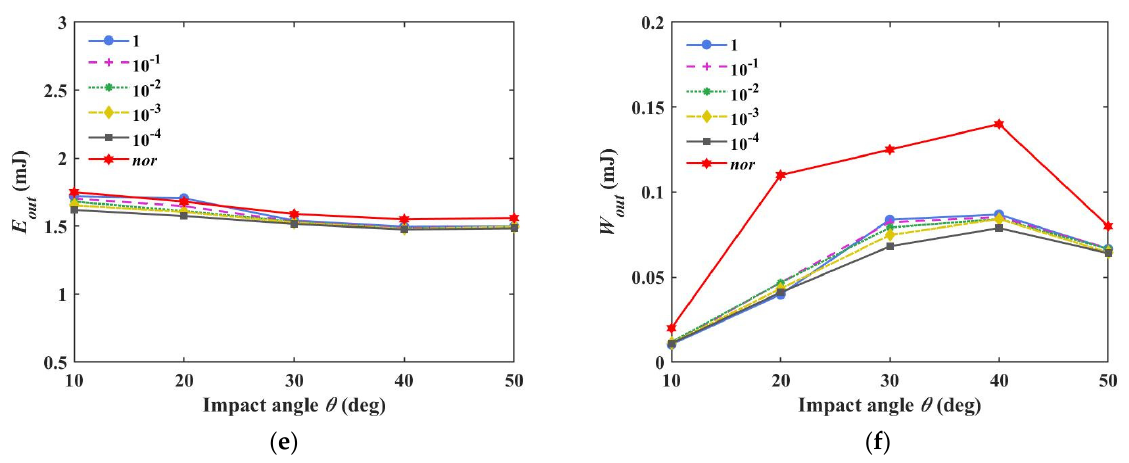
Figure 8. Comparison of the softening simulations. ( a ) normal restitution coefficient; ( b ) tangential restitution coefficient; ( c ) outgoing angular velocity; ( d ) rebound angle; ( e ) translational energy; ( f ) rotational energy.